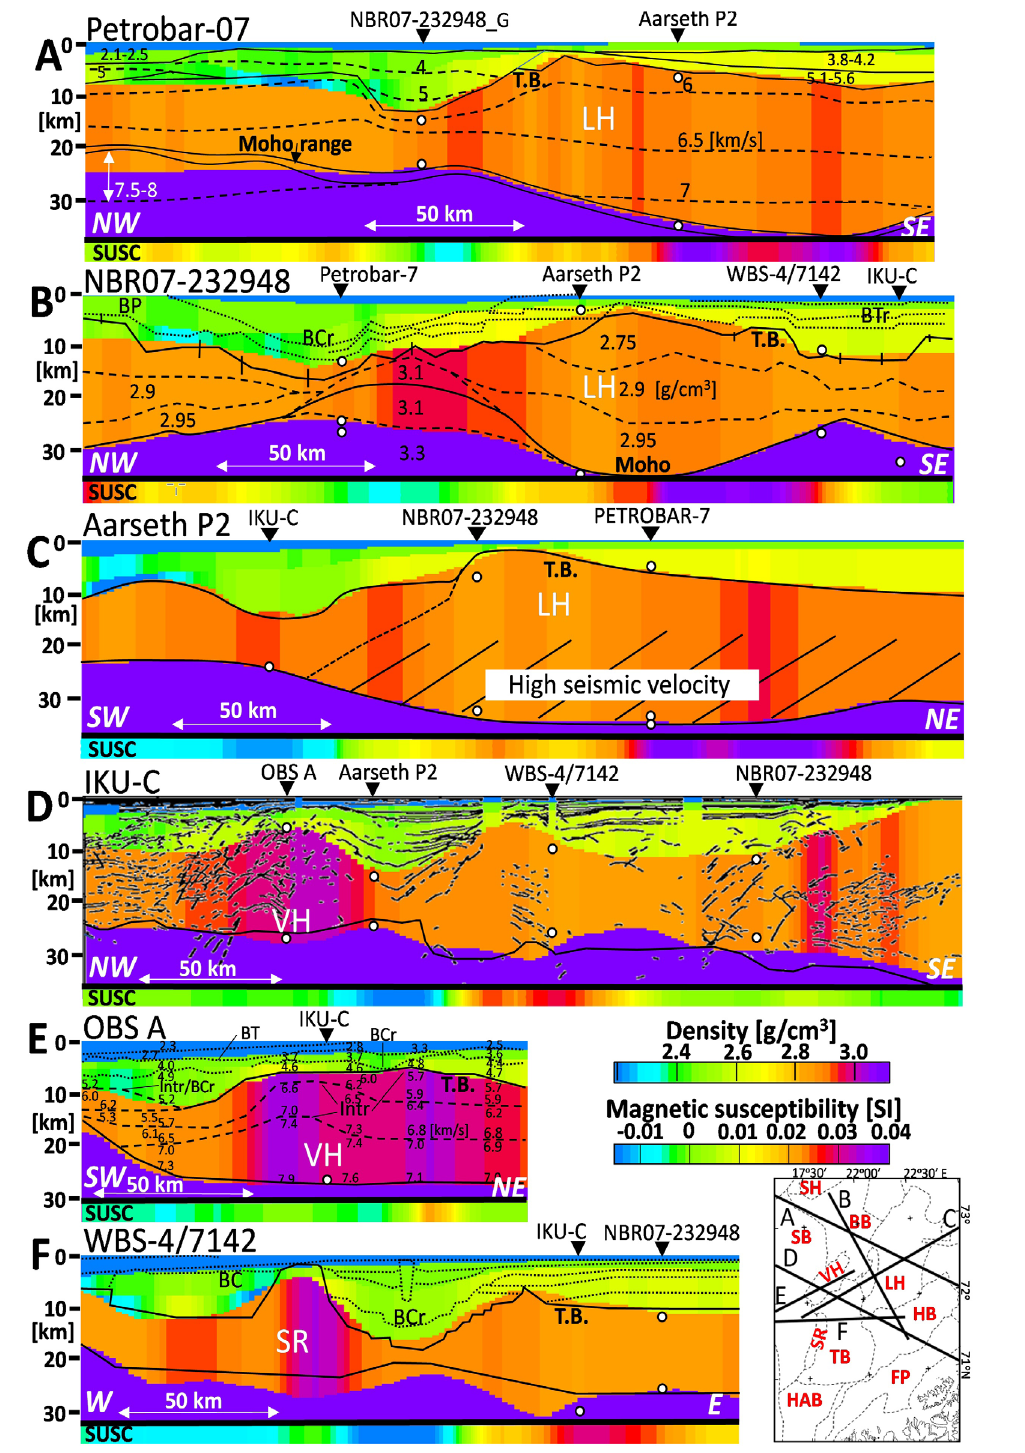
Figure 10. Sedimentary and crustal densities superimposed on the seismic profiles as extracted from the final density model (Table 1). Crustal magnetic susceptibilities (SUSC) are shown on the bar below the profiles as extracted from the final model of the crustal magnetic susceptibilities (Fig. 7F). (A) Petrobar-07 (Clark et al., 2013), black numbers–seismic velocities [km/s]. (B) NBR07-232948 (Gernigon et al., 2014), vertical black lines on the T.B. (top crystalline basement) reflector mark uncertainties, black numbers–densities [g/cm 3 ]. (C) OBS Line 1 (Aarseth, 2018). (D) IKU-C (Ritzmann & Faleide, 2007), black lines–line drawings. (E) OBS A (Mjelde et al., 2002), black numbers–seismic velocities [km/s]. (F) WBS-4/7142 (Breivik et al., 1999; Faleide et al., 2008). BT – Base Tertiary, BC – Base Cenozoic, BCr – Base Cretaceous, BTr – Base Trias, BP – Base Permian, T.B. –top crystalline basement, Intr-Magmatic intrusions. At cross points between the seismic profiles, white circles mark the top crystalline basement and Moho depths of the crossing profile. Inset with seismic profiles (black lines, details in Fig. 1), boundaries of structural elements (black dashed, details in Fig. 1, abbreviations in Fig.